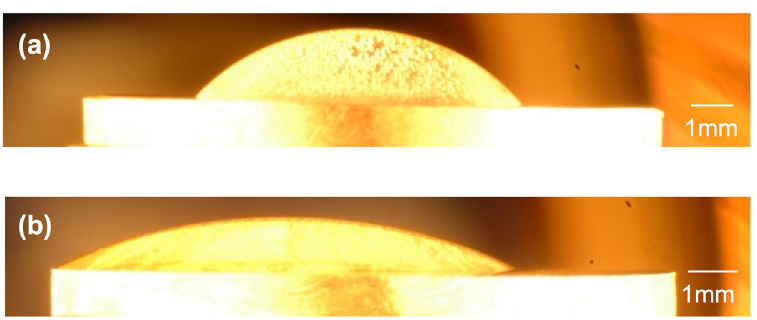
Figure 5. Horizontal view of drop shapes on platinum substrate at 1473 K under ( a ) Ar and ( b ) dry–air